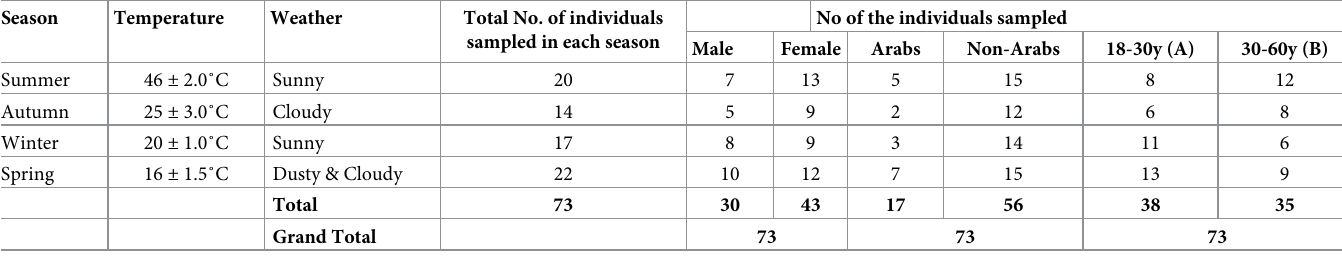
Table 1. Sampling schedule and demographic features of health care workers stationed in a clinical research laboratory of Kuwait.